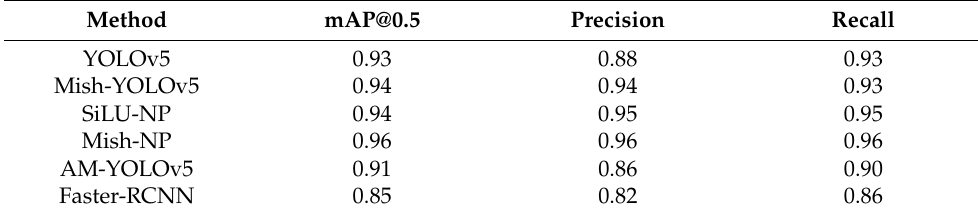
Table 1. Comparison of four